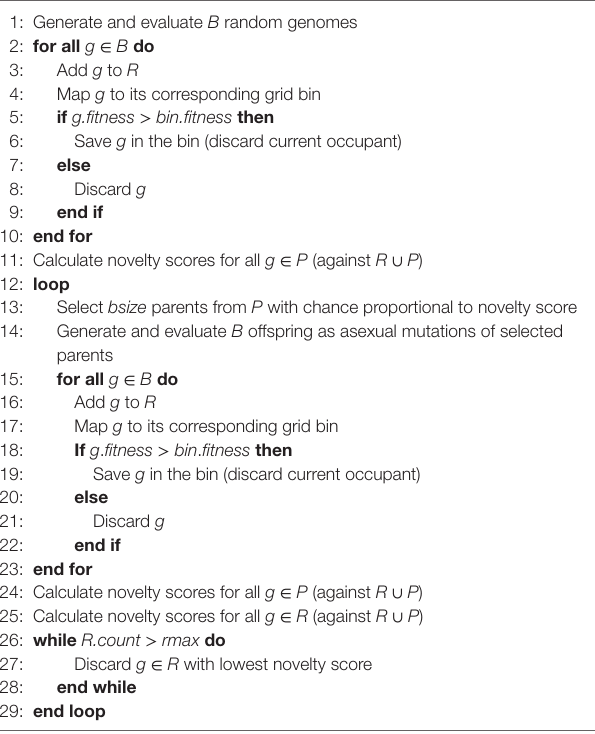
algorithm 1 | MaP-elites + novelty (MenOV)